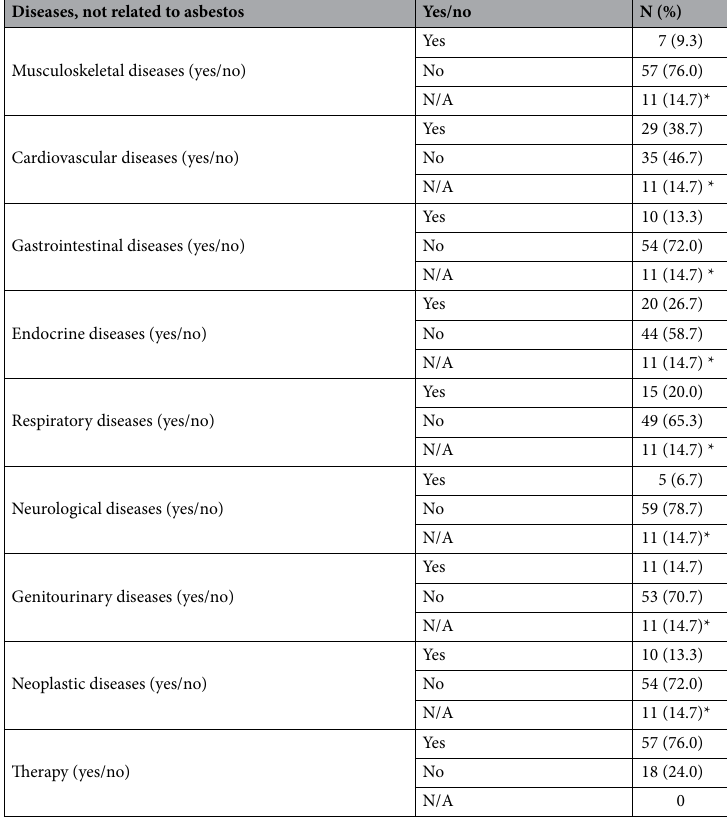
Table 2. Clinicopathological characteristics of the WEA cohort. *Data available for 64 out of 75 (85.3%)